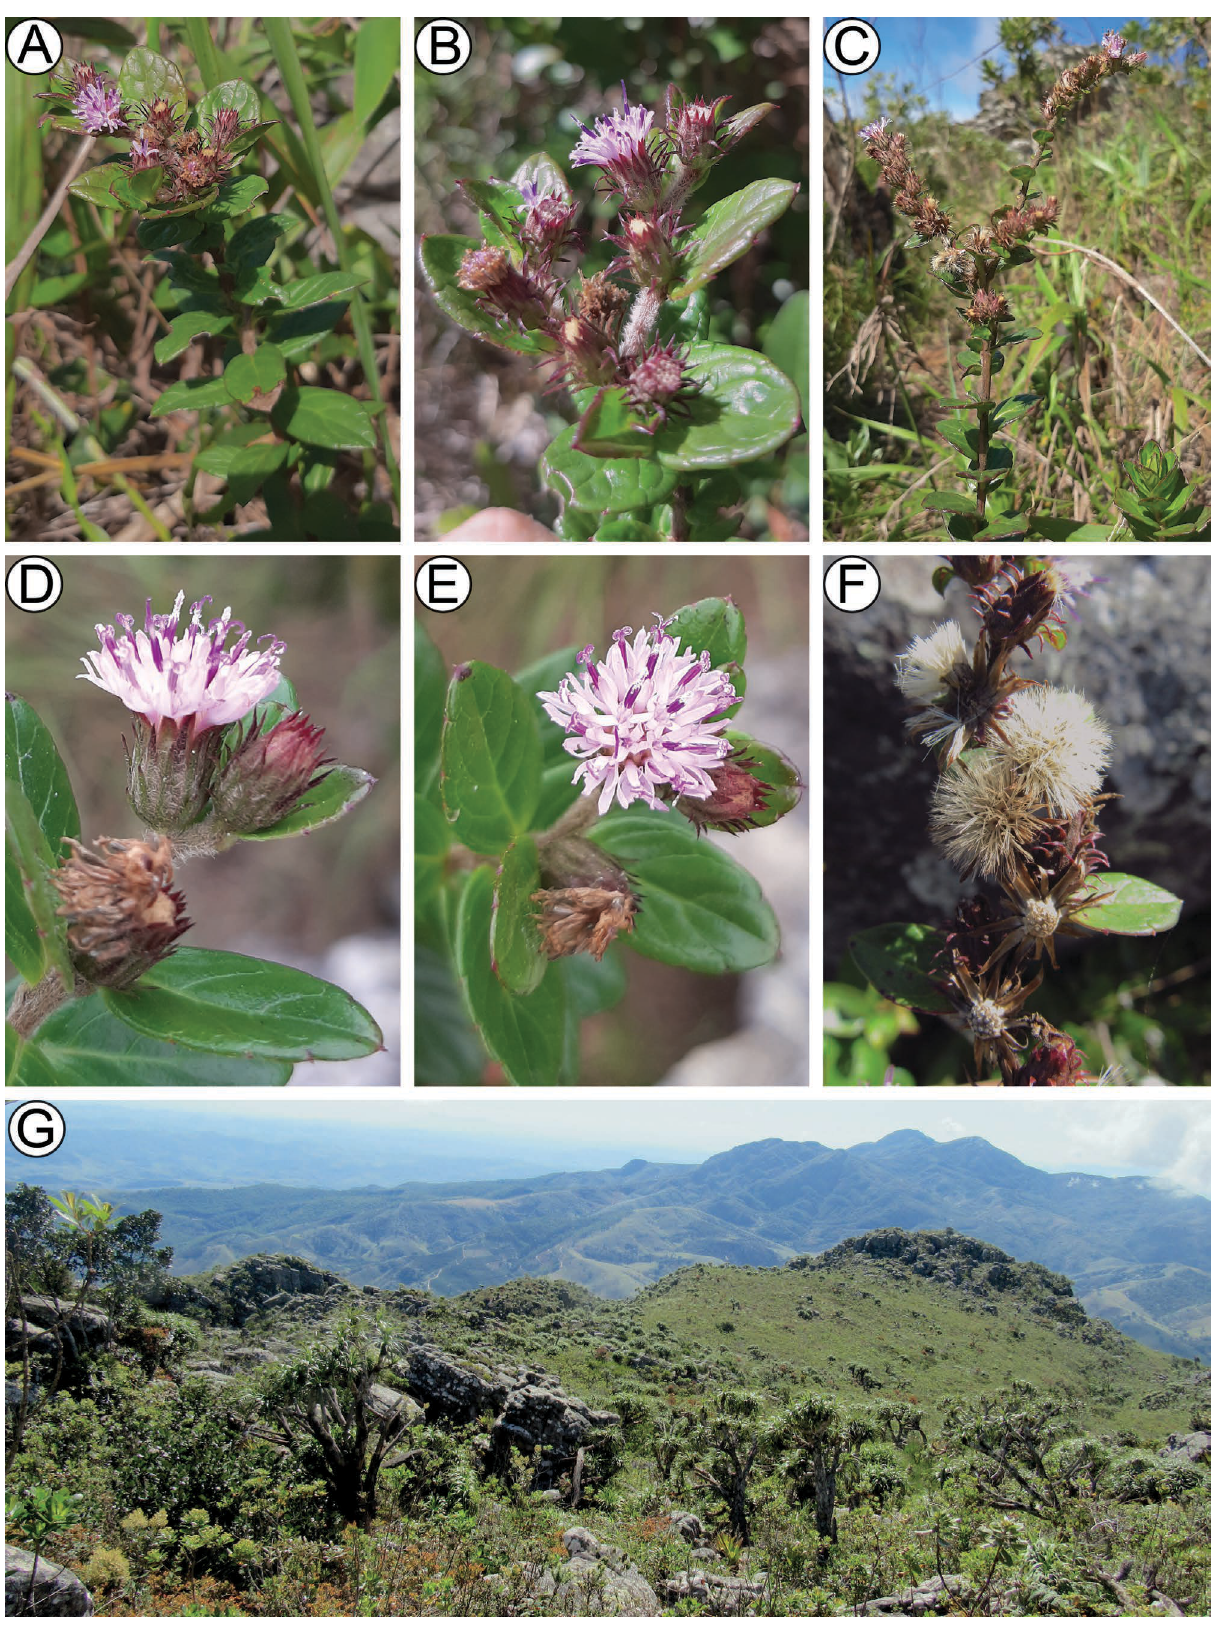
Figure 2 – Lepidaploa campirupestris Antar & Loeuille. A . Habit. B – C . Inflorescence. D – E . Capitula with florets at anthesis. F . Mature capitula. G . Habitat. All photographs by Paulo M.